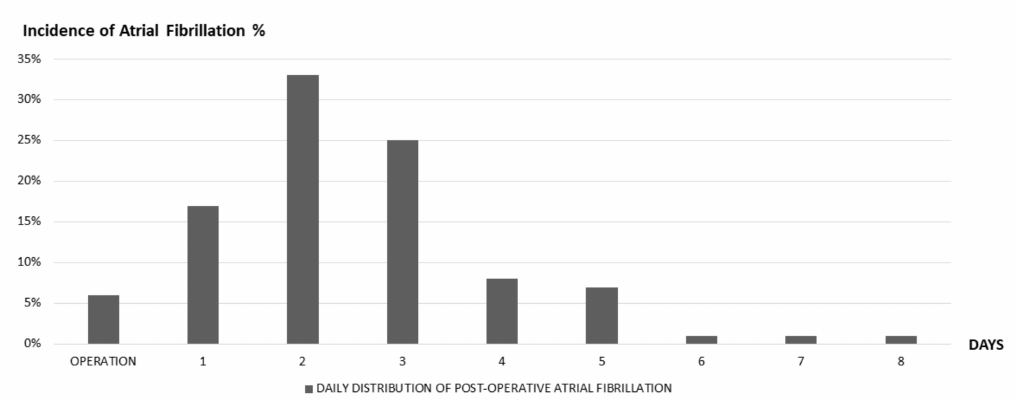
Figure 1. Daily distribution of post-operative atrial fibrillation—Pooled data with permission from [22,30,31], showing cumulative incidence of post-operative atrial fibrillation episodes, according to days after